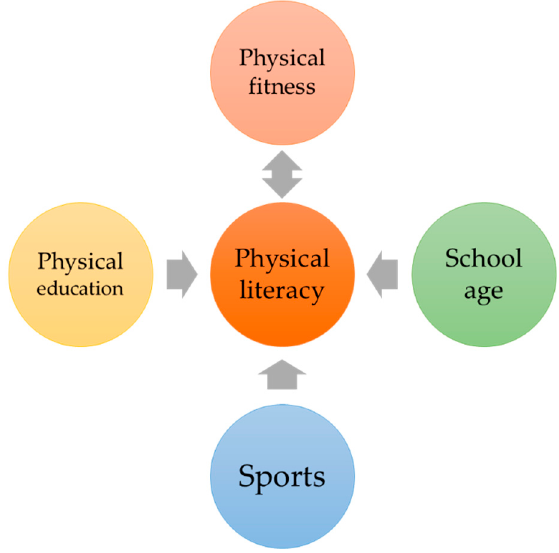
Figure 1. Concept and design of the study.